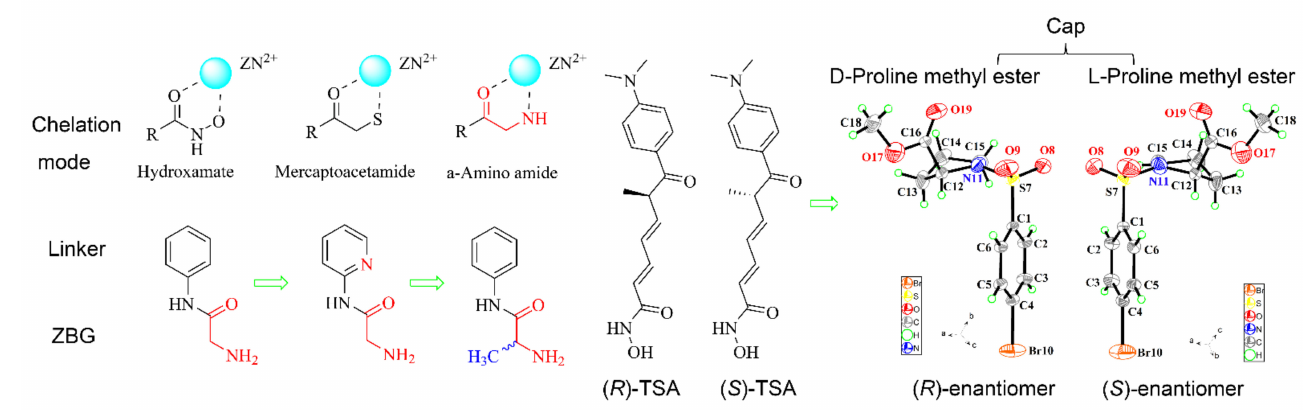
Figure 3. The design of cap, linker, and zinc-binding